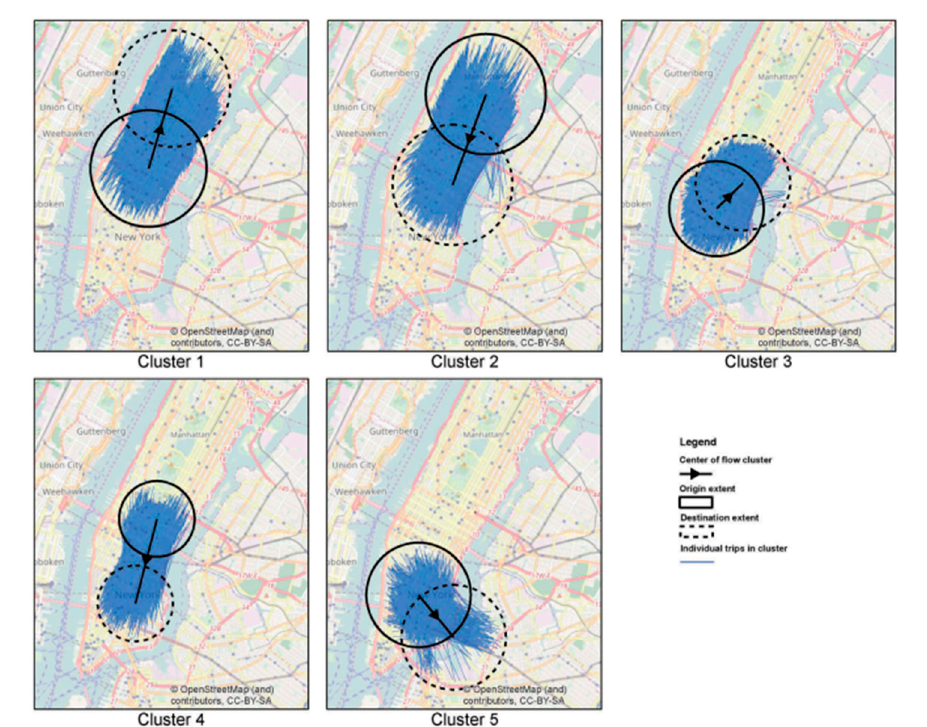
ISPRS Int. J. Geo-Inf. 2019 , 8 , 477 Figure 14. Centers of the flow clusters with different volumes. Figure 14. Centers of the flow clusters with di ff erent volumes.